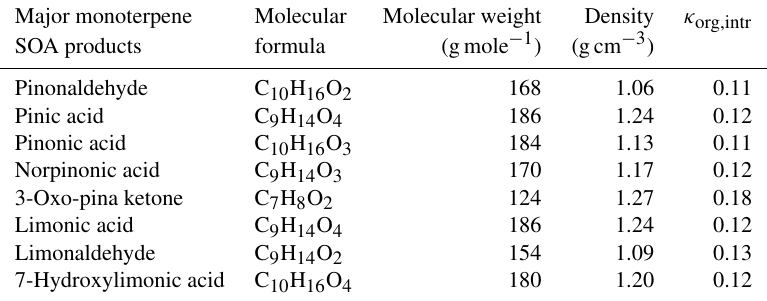
Table 1. The molecular formula, molecular weight, density, and intrinsic organic hygroscopicity derived using Eq. (2) for major monoterpene SOA products. The density was calculated from O : C and O : H values (Kuwata et al.,